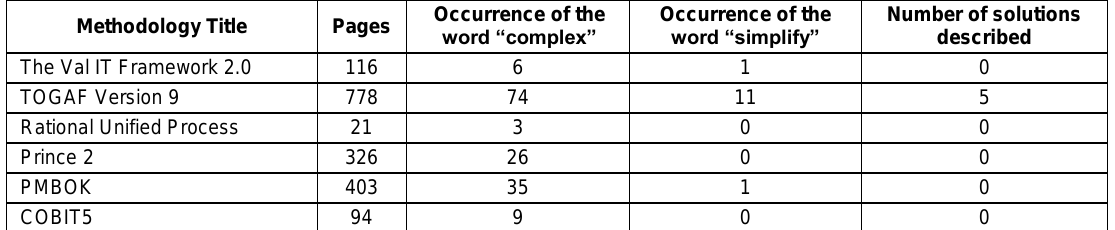
Table 1. Occurrences of the word “complex” in various methodologies; source: